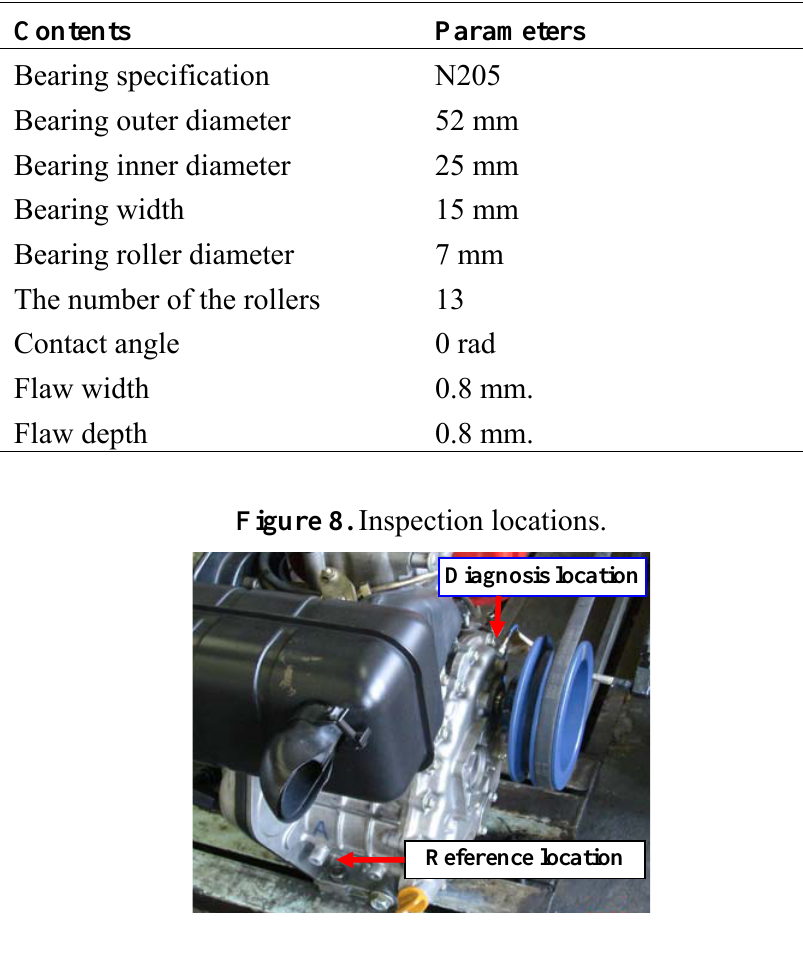
Table 1. Bearing information for verification.